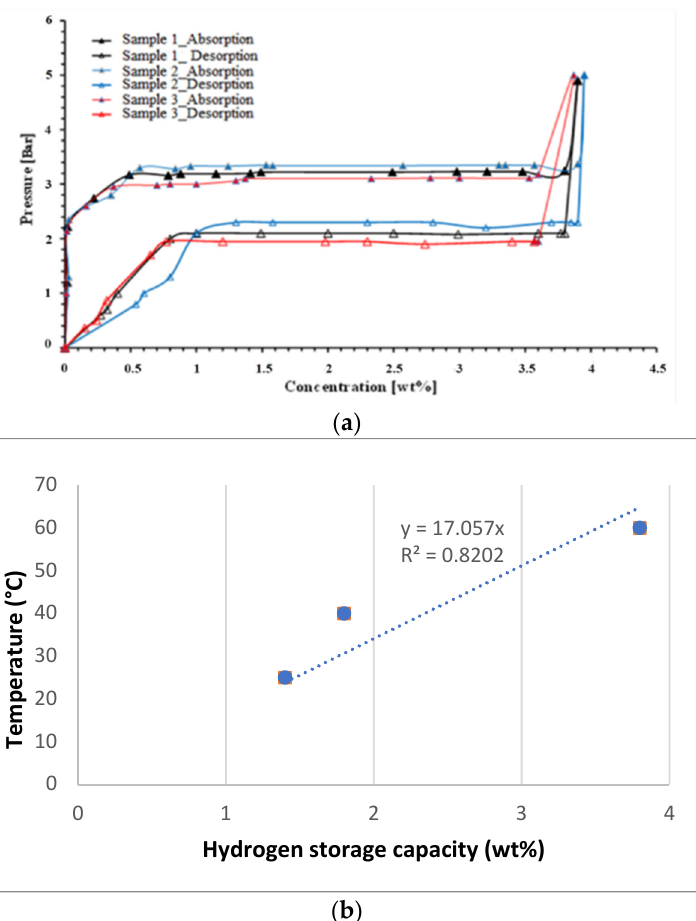
Figure 7. ( a ) PCT Curves of LaCrO 3 at 333 K, ( b ) Evolution of hydrogen storage with temperature.